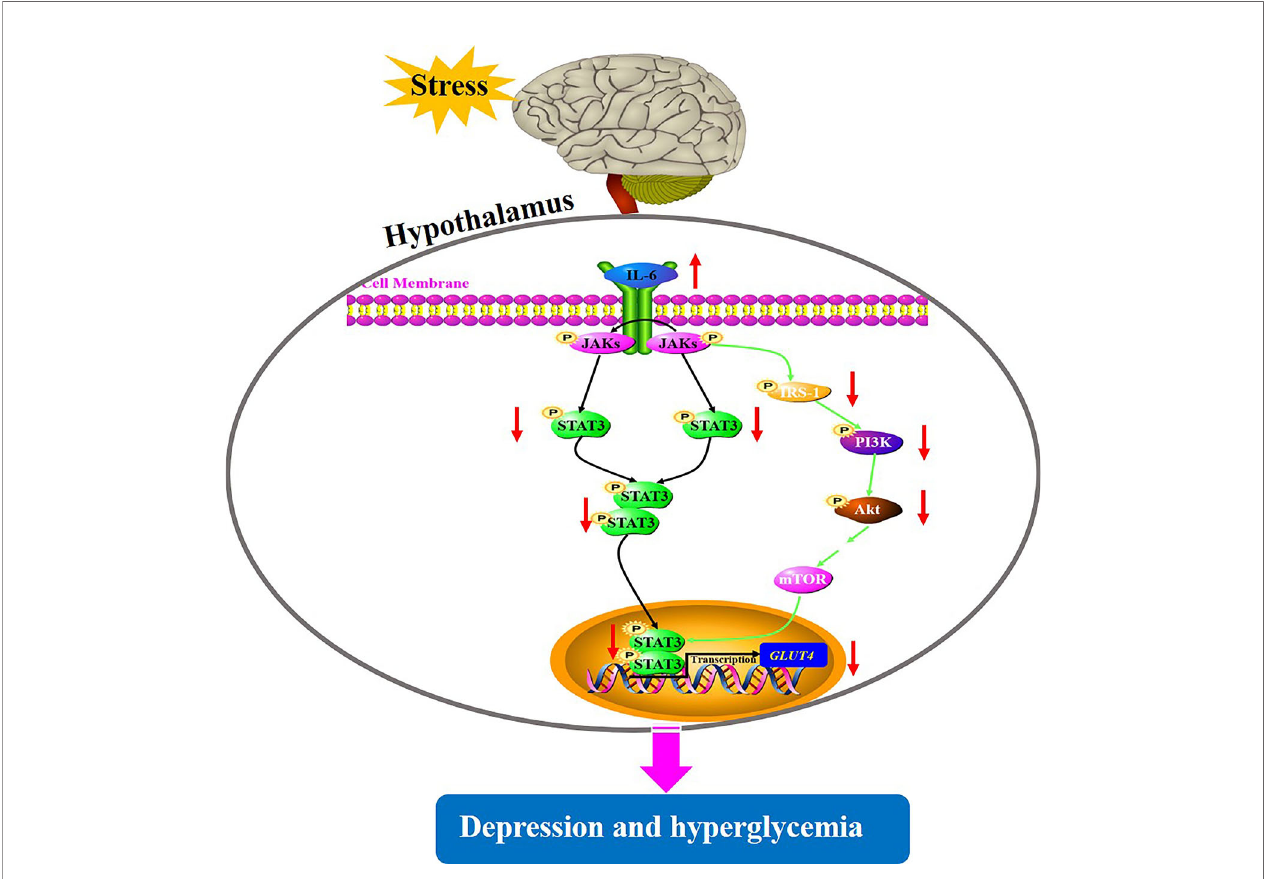
FIGURE 9 | A putative mechanism underlying depression-like behavior susceptibility to hyperglycemia in rats, which is likely to be associated with the activation of IL-6-mediated inhibition of glucose homeostasis signaling in the